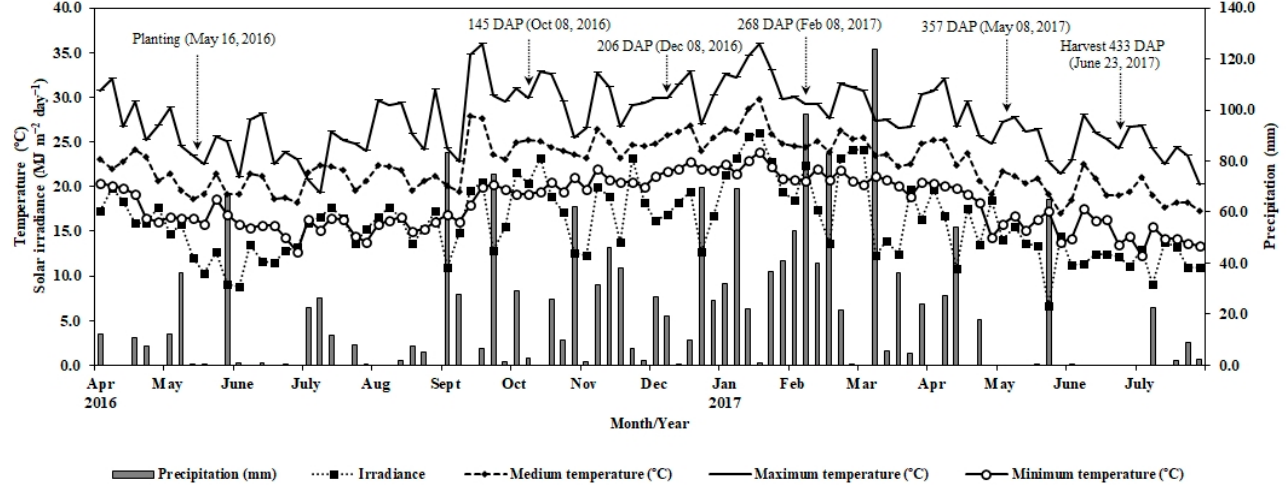
Figure 1. Rainfall (mm), medium, maximum, and minimum temperatures, and solar irradiance, rec- orded at the Meteorological Station of the National Institute of Meteorology (INMET) in Lençóis Paulista, SP, Brazil, from April 2016 to July